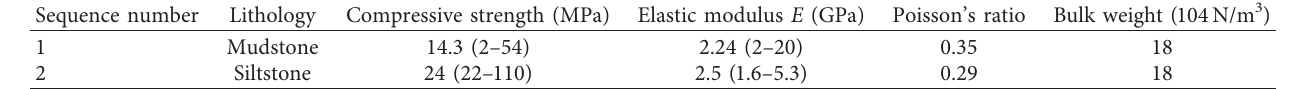
Table 1: Mechanical properties of the rock.